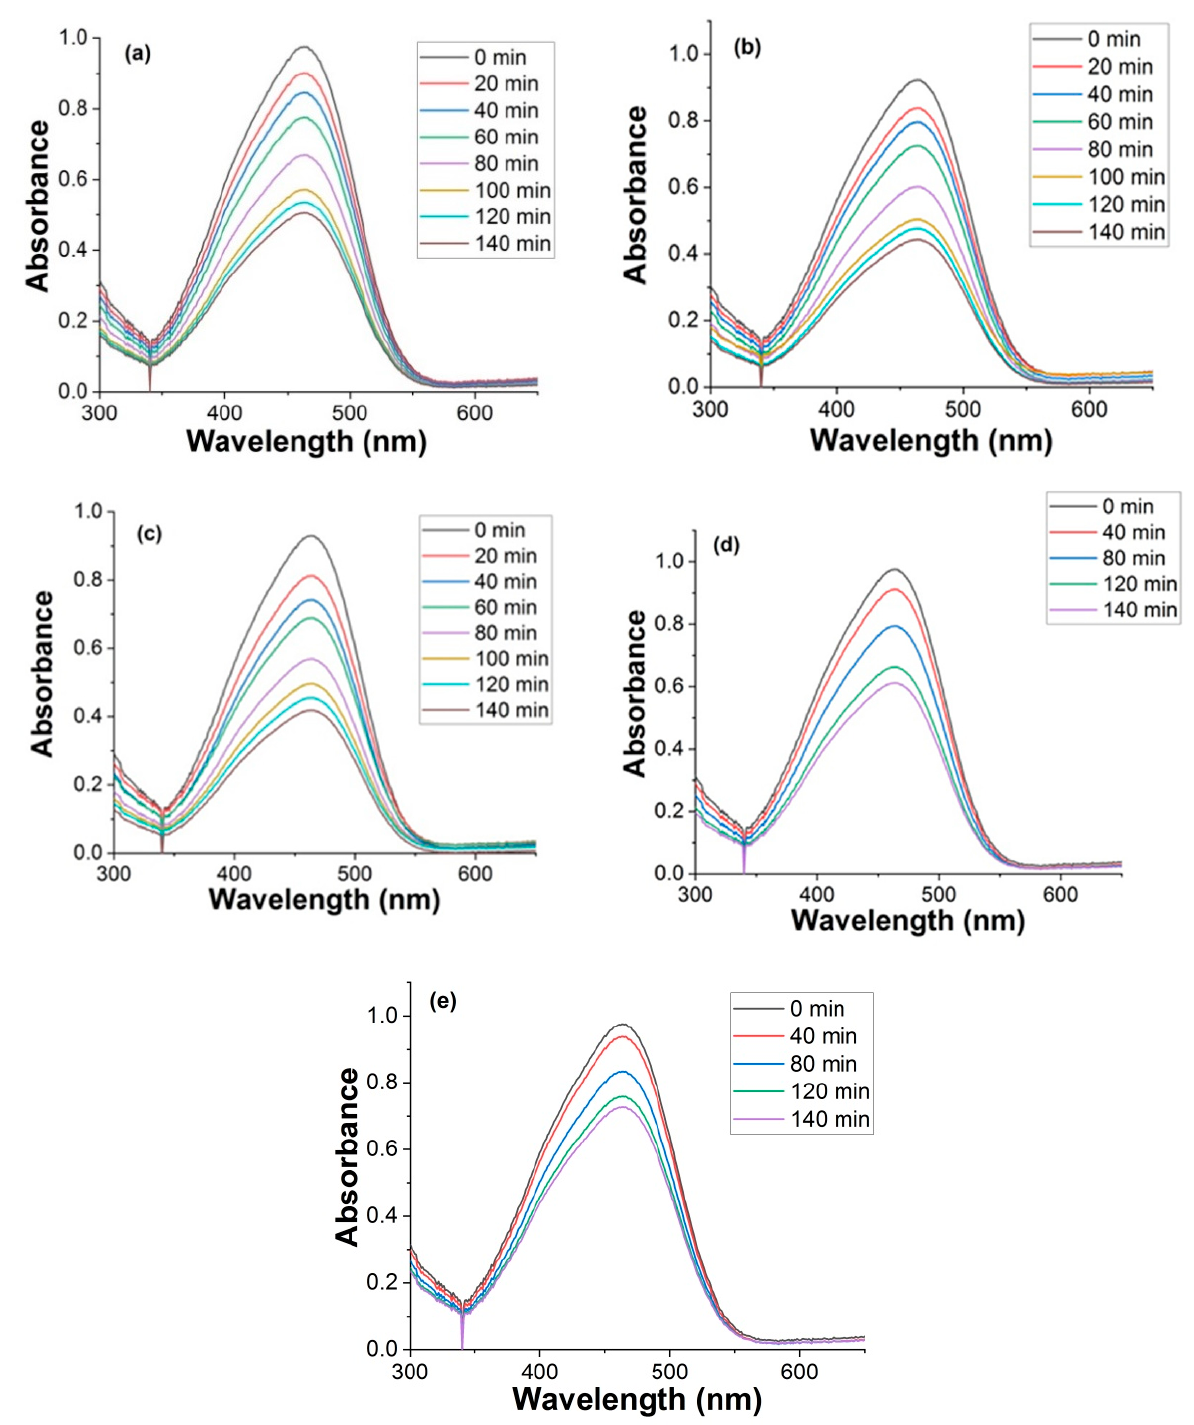
Figure 7. ( a ) Zr1CrO 2 , ( b ) Zr3CrO 2 , ( c ) Zr5CrO 2 , ( d ) Zr7CrO 2 , and ( e ) Zr9CrO 2 degradation of MO dye vs. contact time.